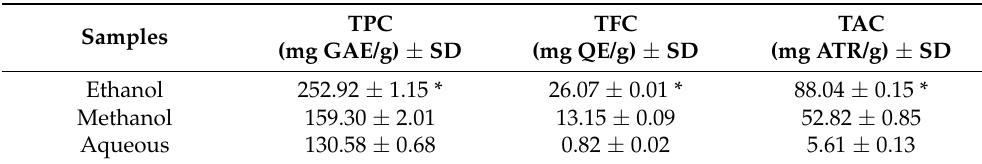
Table 1. TPC (mg GAE/g extract), TFC (mg QE/g extract), and TAC (mg ATR/g extract) of kratom leaf extracts.